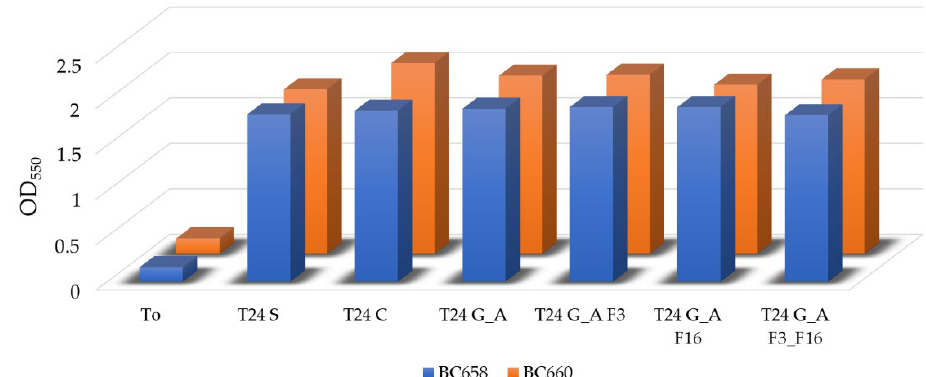
16 of 28 Figure 16. Percentage of area covered by adhered diatoms and Gram-negative bacteria as estimated by SEM imaging. 2.4. Evaluation of Toxicity of the Coating against Bacteria and Diatoms No biocide-release effect was observed against both the Gram-positive and Gram- negative bacteria. In fact, the OD 550 measured before and after the experiment showed an increment of turbidity of 10-fold (from OD 550 0.17–0.18 to an average of OD 550 1.88 to 1.93, respectively, for BC658 and BC660 (Figure 17).